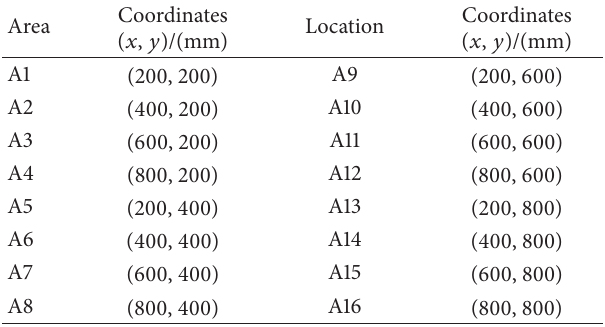
Figure 6: Signal acquisition locations for identifying a through- thickness hole in aluminum plate (unit: mm). Table 2: Coordinates of signal acquisition locations on aluminum plate.